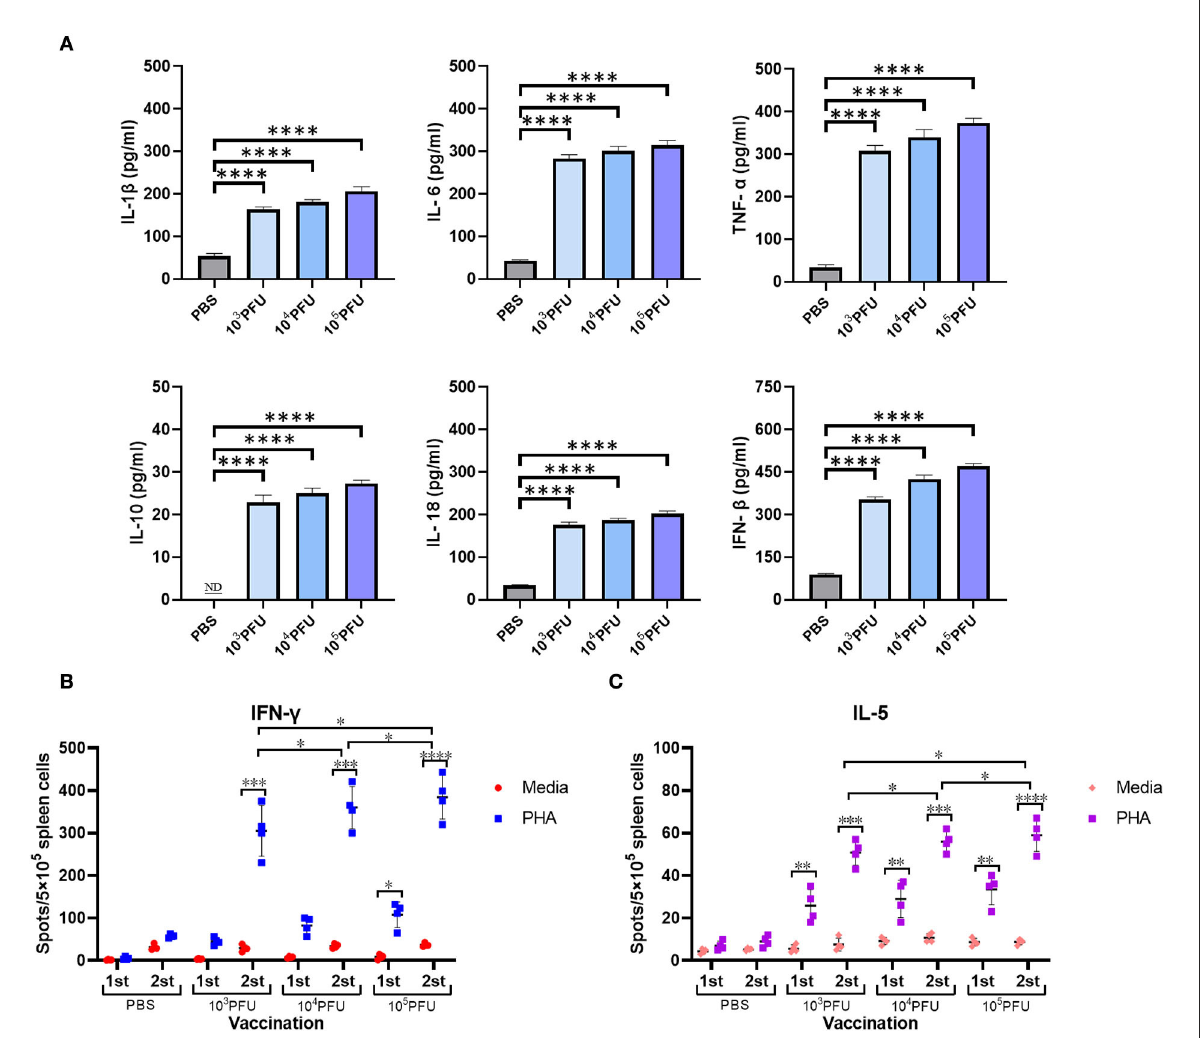
FIGURE7 Cytokine secretion in intranasally vaccinated mice. Mice serum was collected at 3 days postinfection for analysis by ELISA to determine cytokine levels (A) . The number of antigen-specific splenocytes secreting IFN- γ (B) or IL-5 (C) was determined by ELISpot. ND, nondetected. Each sample was tested in triplicate. The values represent the means ± standard deviations (SD). The dots represent the individual mice. ns indicates not significant. ( p > 0.05), *( p ≤ 0.05), **( p ≤ 0.01), ***( p ≤ 0.001),****( p ≤